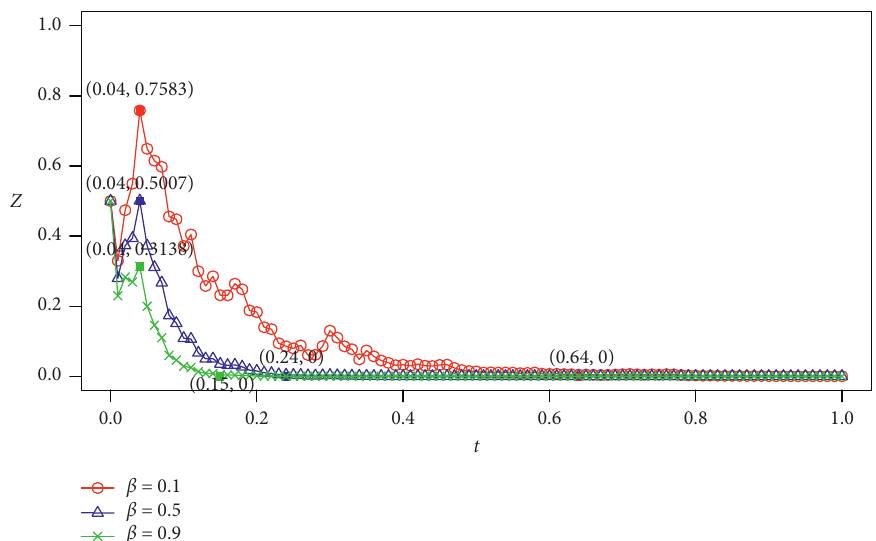
Figure 7: The impact of the degree of punishment β on loan enterprise’s strategy selection. Table 2: Impact of incentive and penalty parameters on the convergence rate of subject strategy. Value of parameters The moment of the proportion of noncooperative strategies first reaching zero Change in convergence rate